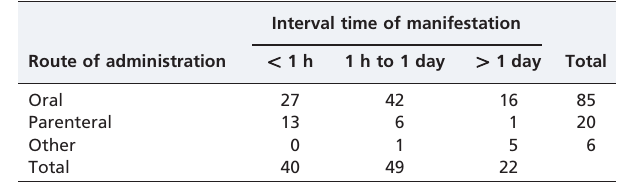
Table 3 - Chronology of the reactions according to the route of